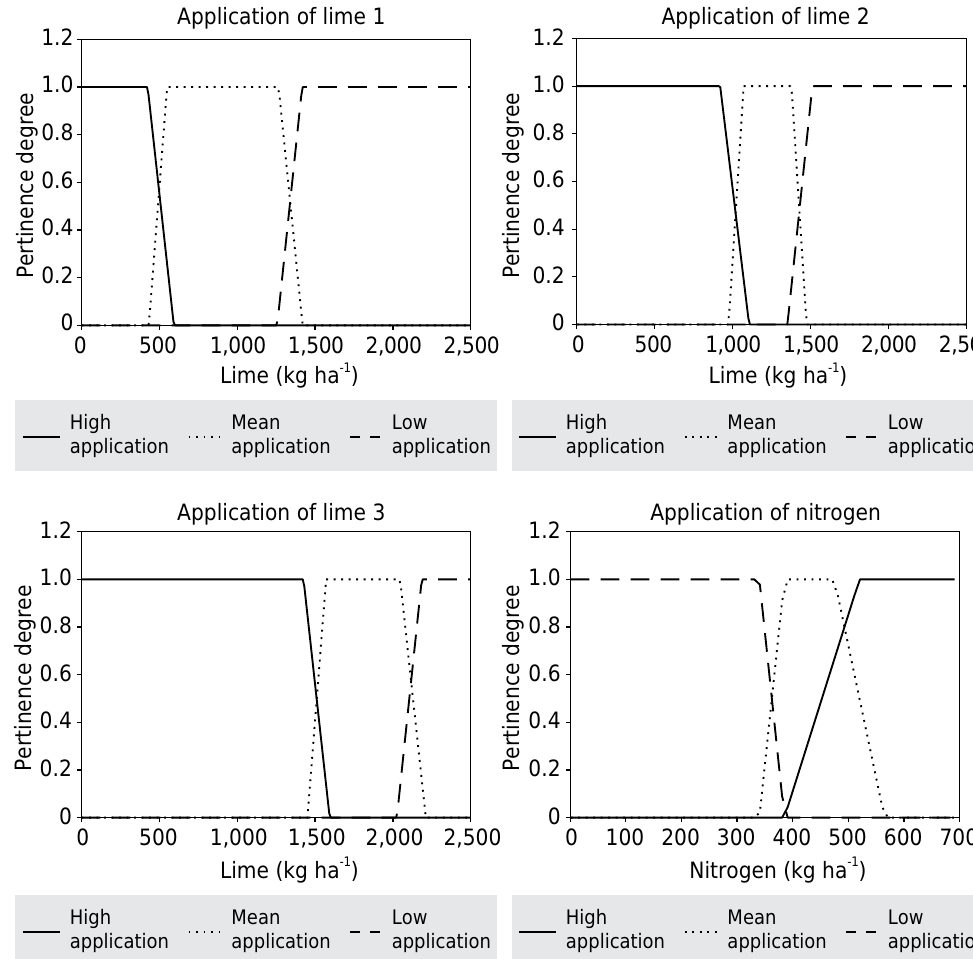
Figure 6. Fuzzy sets for the input variable of lime application need in the three crops and